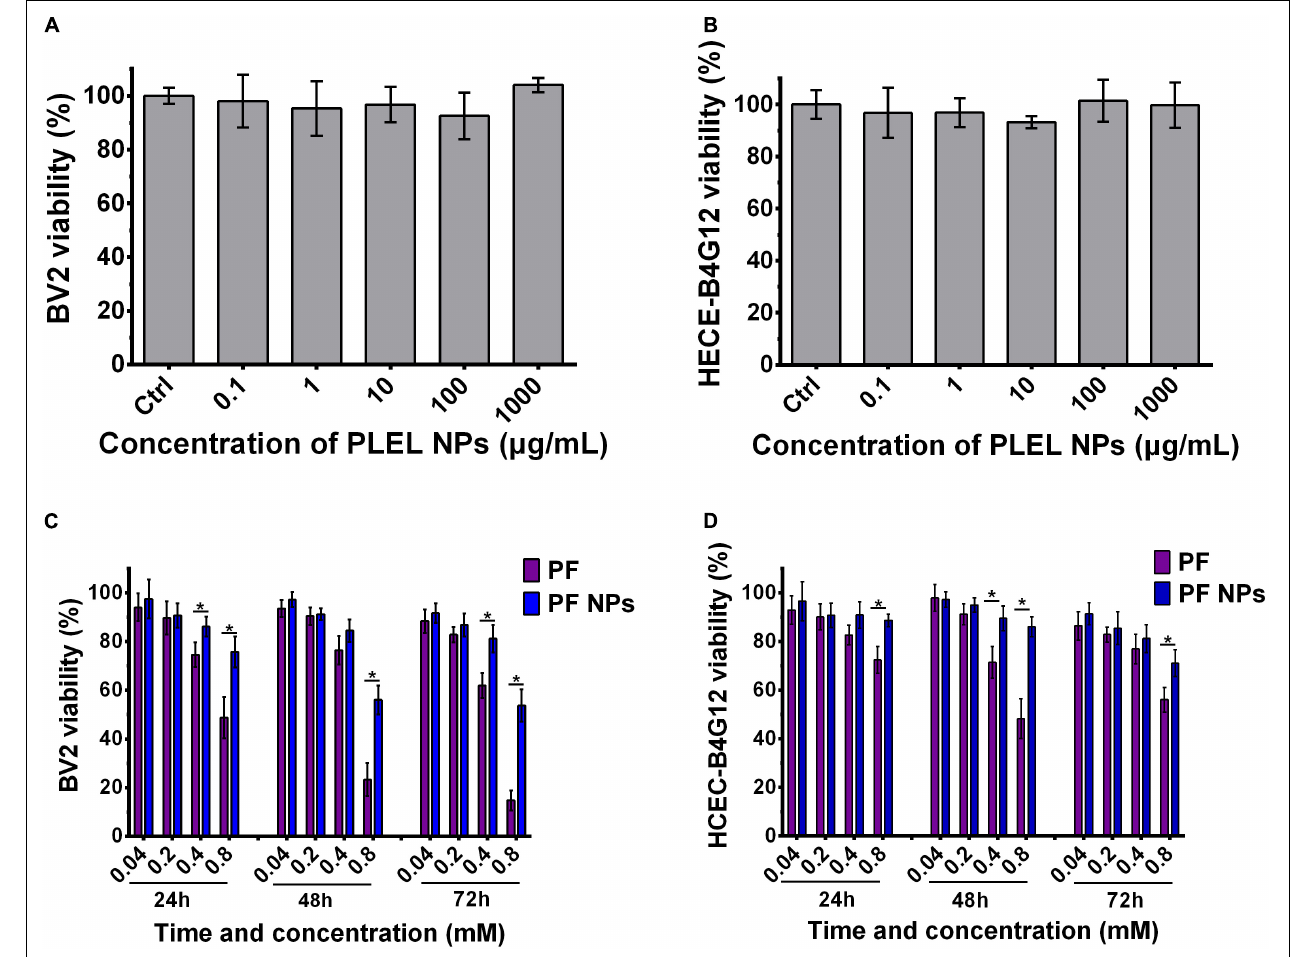
FIGURE 5 | Cell viability of PLEL, PF, and PF NPs with various concentrations and testing times. (A,B) BV2 and HCEC-B4G12 cells cultured for 72 h ( n = 5). (C,D) BV2 and HCEC-B4G12 cells were treated with pure PF and PF NPs from 24 to 72 h ( n = 4). *Indicated a statistically significance ( p <